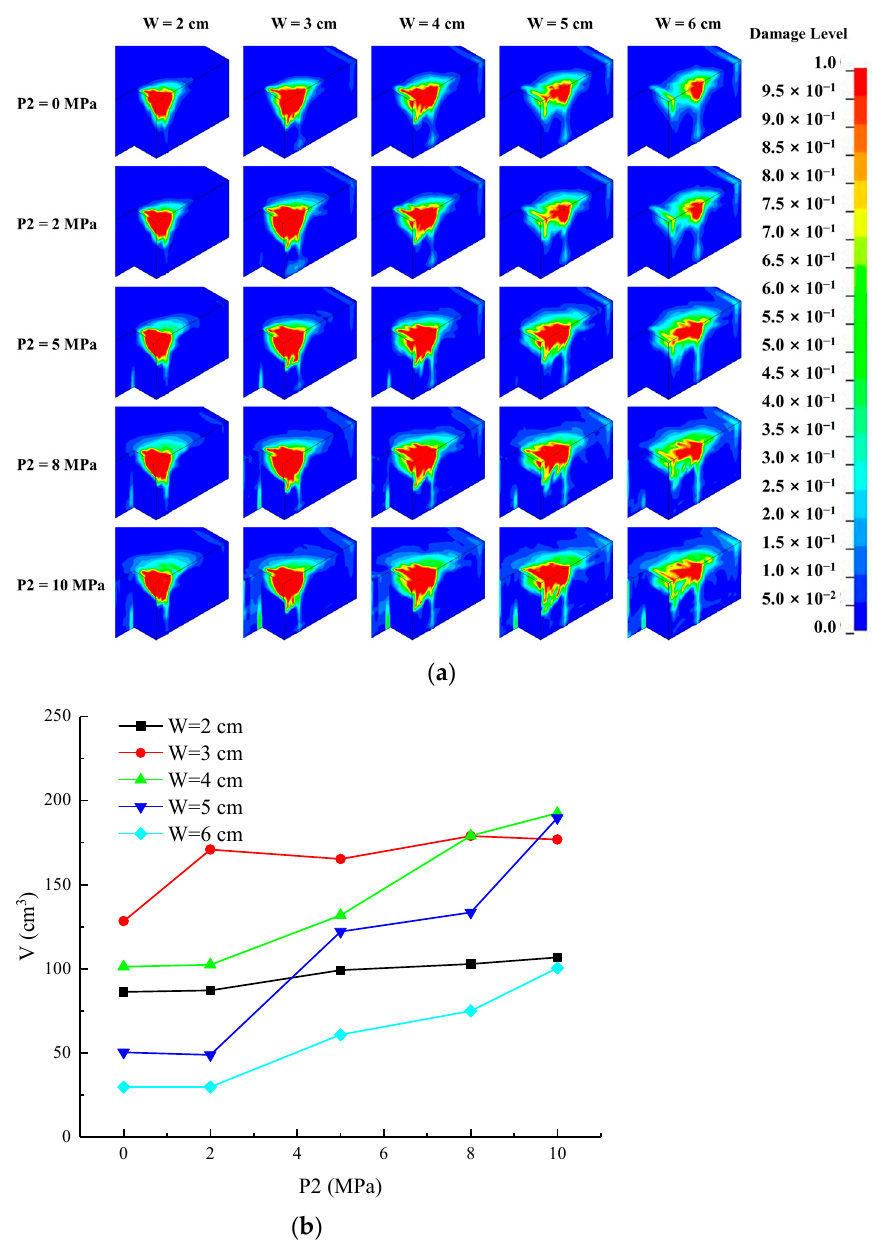
Figure 8. Damage contours at cut Z1 and crater volumes for each burden under different P2: ( a ) damage contours; ( b ) crater volumes.